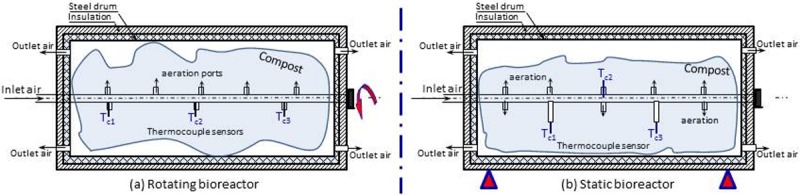
Cross-sectional views of the (a) rotating bioreactor and (b) static bioreactor Showing the inlet and outlet aeration ports and the locations of thermocouple sensors.